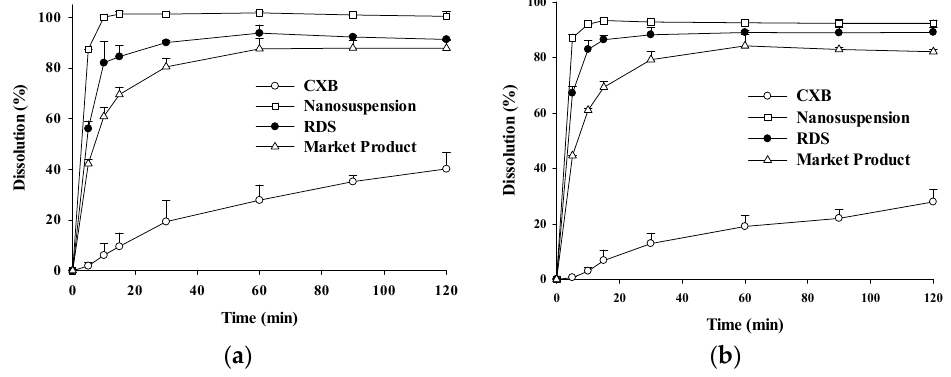
Figure 6. The dissolution profiles of CXB in ( A ) pH 1.2 and ( B ) pH 6.8 medium at 36.5 ± 0.5 °C from CXB, Nanosuspension, RDS, and marketed product.